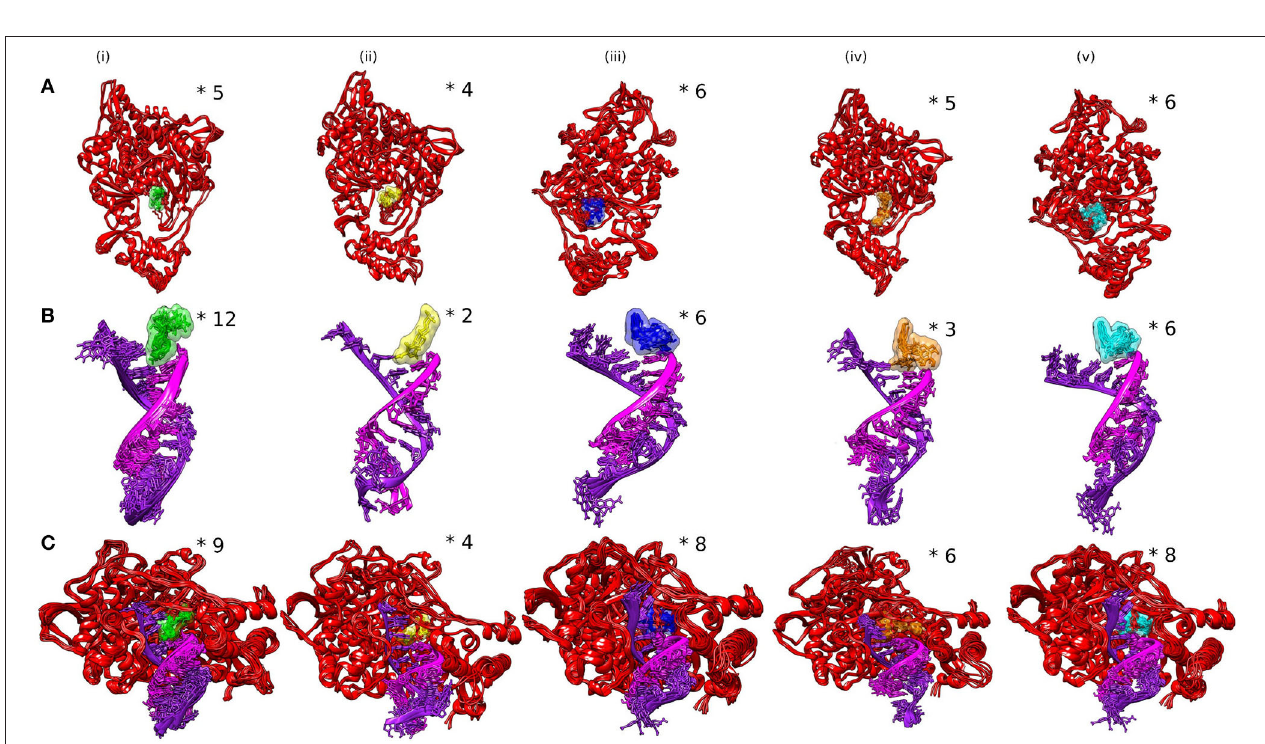
FIGURE 4 | Analysis of SARS-CoV-2 complexes shown as clusters of (A) RdRp–ligands, (B) RdRp–RNA, and (C) RdRp–RNA–ligands. Numbers of clusters are represented by asterisk.